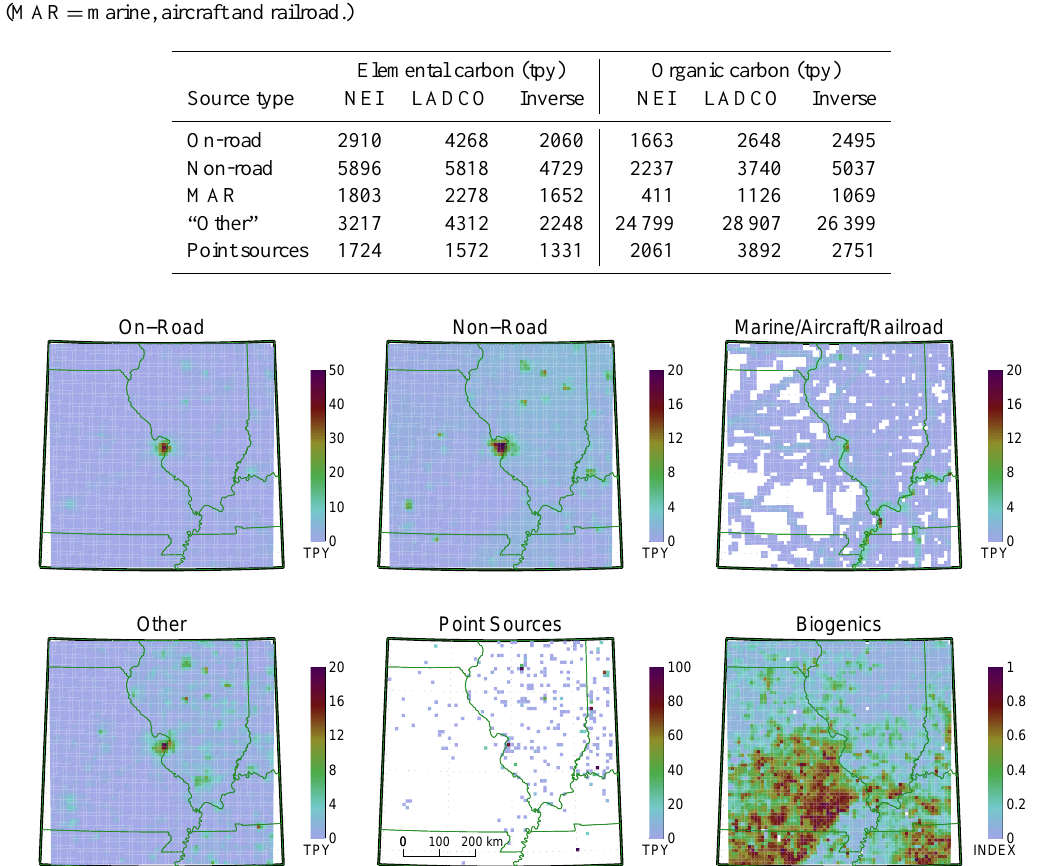
Figure 2. Elemental carbon emissions by source type from the LADCO inventory for the Regional domain in metric tonnes per year, and biogenic tracer emissions in non-dimensional